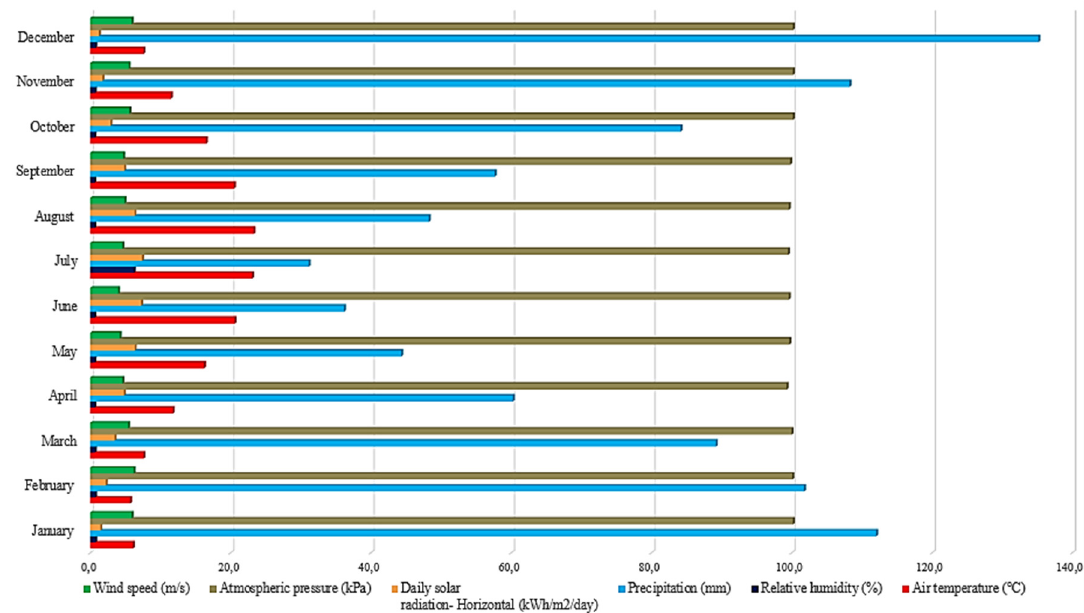
Figure 3. The drawn chart of climate data in [28] for the current location.